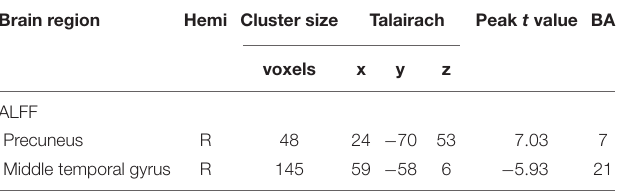
with VAS ( r = 0.29, p < 0.05) ( Figure 2 and Table 5 ).